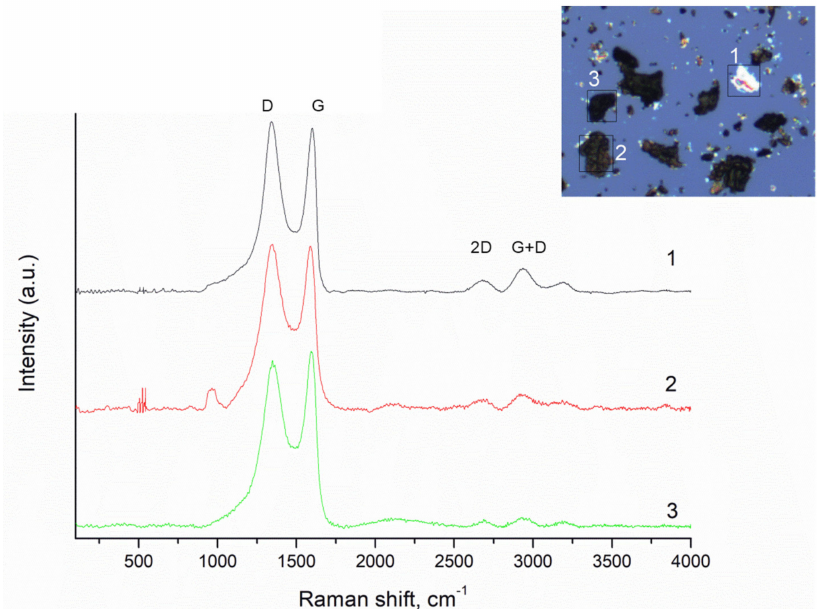
Figure 5. Raman spectrum of GO prepared by Hummers method with proposed deconvolution of the D, G, D (cid:48) , 2D and S3 bands. GO creates two main peaks: G (~1602 cm − 1 ), a primary in-plane vibrational mode, and 2D (2700 cm − 1 ), a second-order overtone of a different in-plane vibration, D (1350 cm − 1 ). D and 2D peak positions are dispersive (dependent on the laser excitation energy). Raman spectra of TGO as seen in Figure 6 show strong D (~1350 cm − 1 ) peaks and G (~1605 cm − 1 ) peaks, suggesting very small crystal sizes. Because the D band is stronger than the G band, the functionalization degree of TGO is higher, which was confirmed also by the XPS method. In general, GO has a highly disordered structure due to many functional groups in the architecture formed during oxidation of graphite powder/flakes.